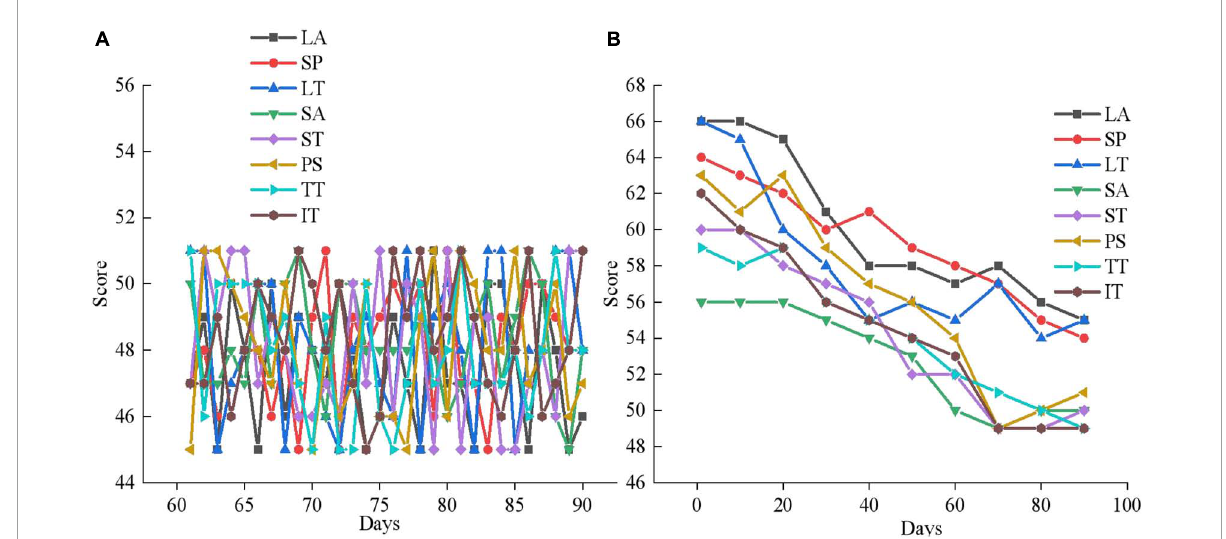
FIGURE14 Mental health outcomes of the experimental group in the third month of therapy. (A) Third month mental health assessment results; (B) The mental health changes of experimental group member 10.